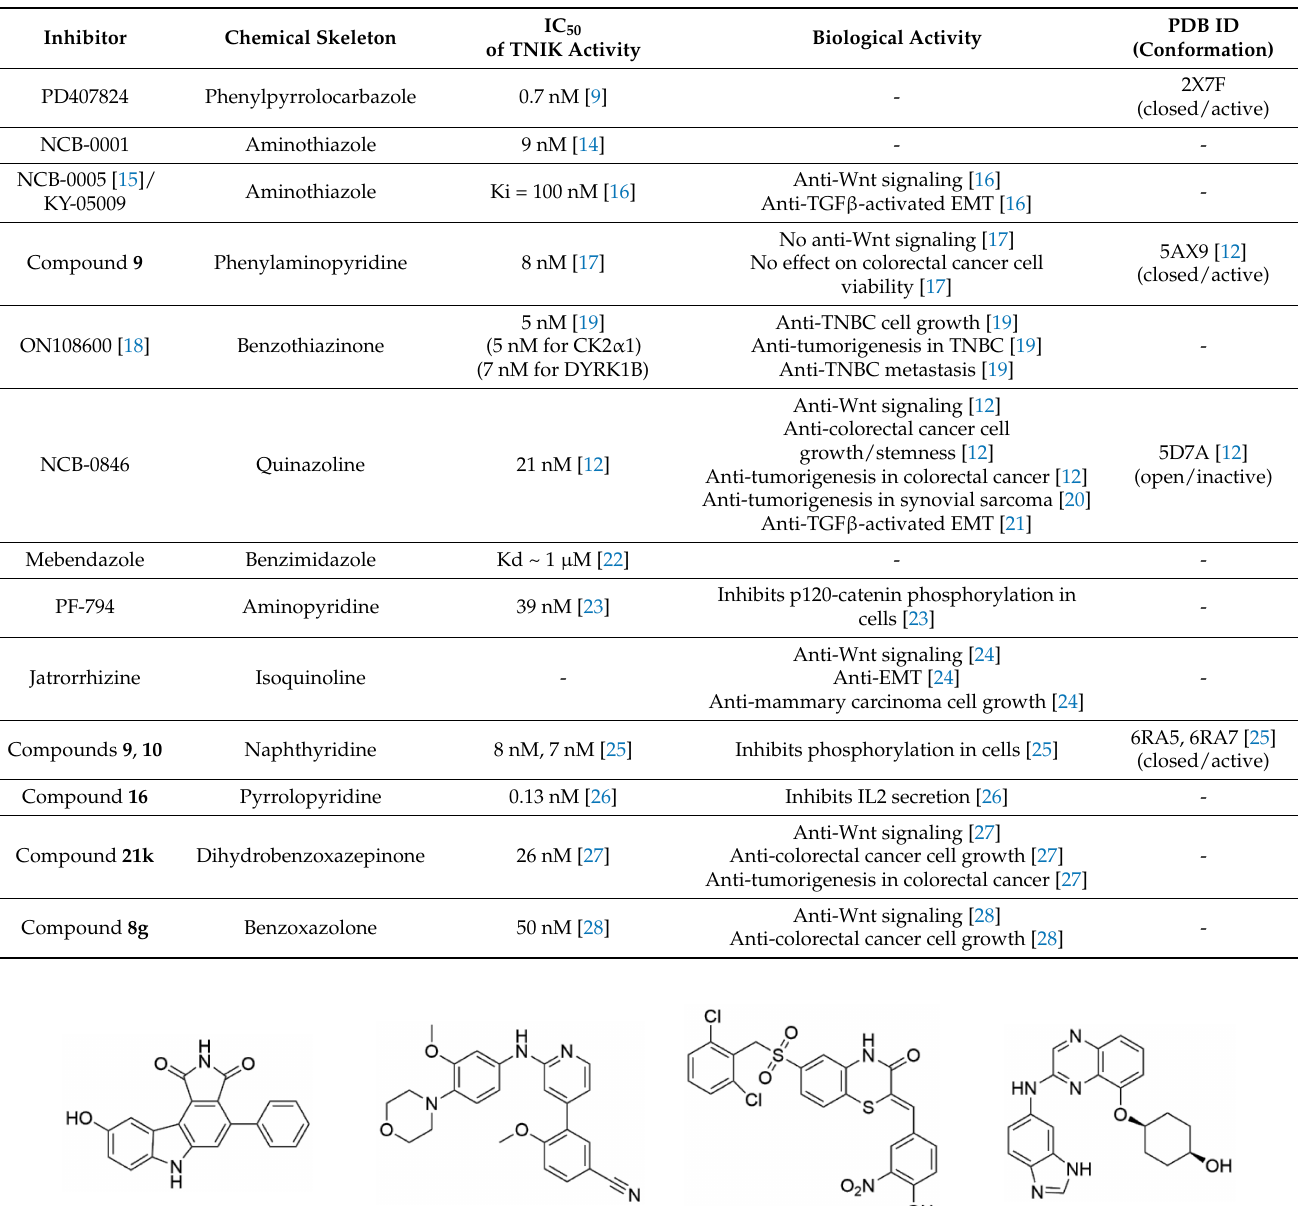
Table 1. TNIK inhibitors and their TNIK-bound structures.